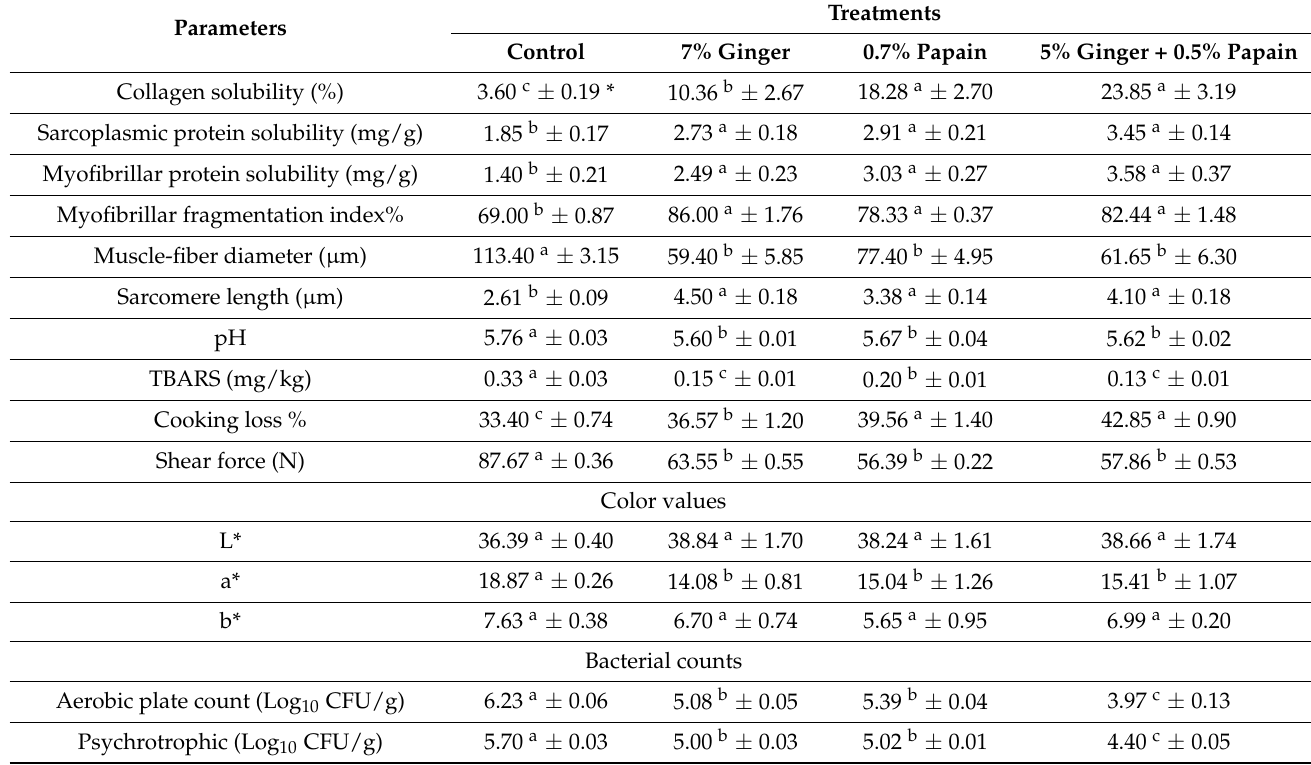
Table 1. Quality attributes of camel semitendinosus muscle after treatment with fresh ginger extract (7%), papain-enzyme powder (0.7%), and their combination (5% ginger and 0.5%